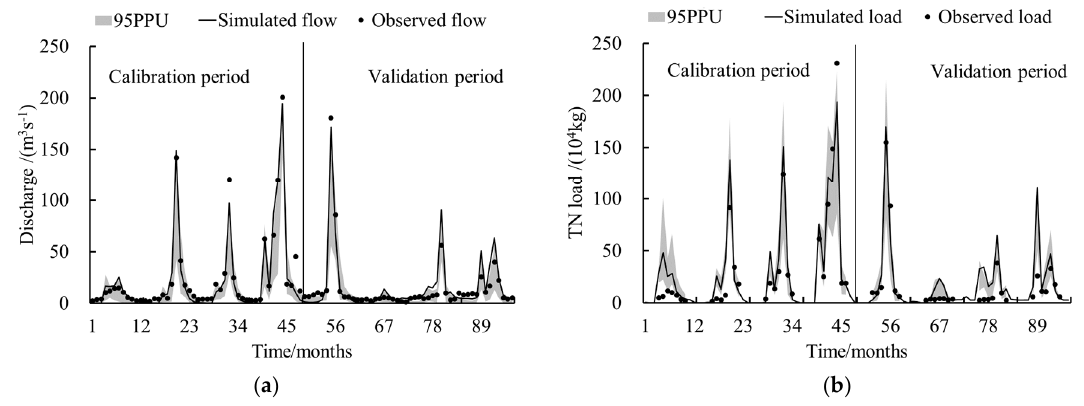
Figure 3. Observed and simulated ( a ) flow and ( b ) TN loads.